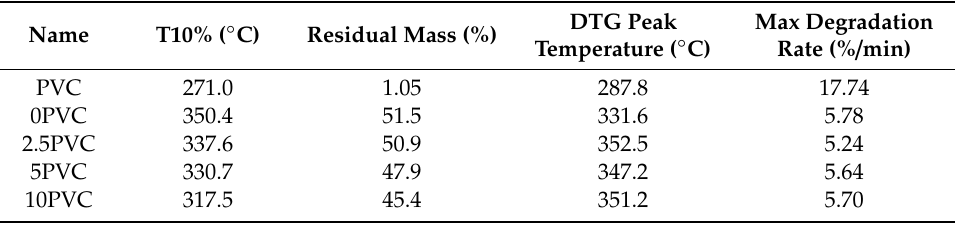
Table 5. TG and DTG values of the materials examined in air atmosphere.